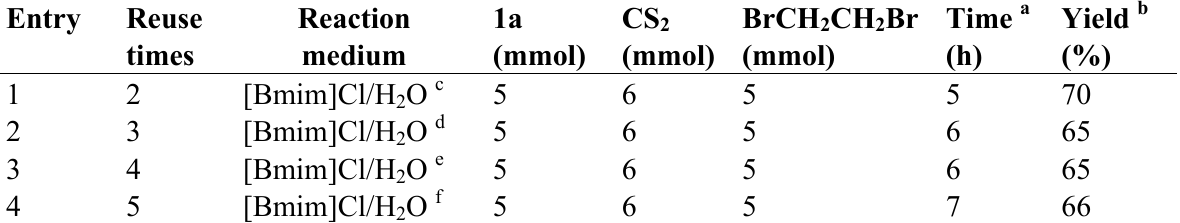
Table 2. Recycling of [Bmim]Cl/water in synthesis of 7a